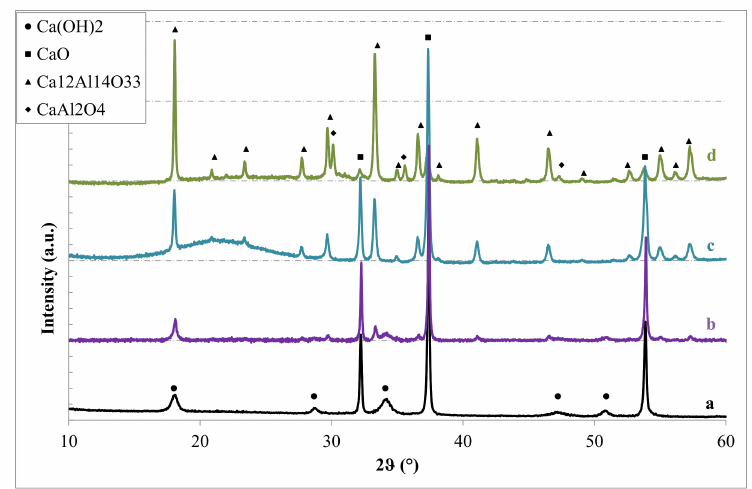
Figure 2. XRD of sorbents synthetized with various CaO contents (a) C100, (b) C85, (c) C56, and (d) May.